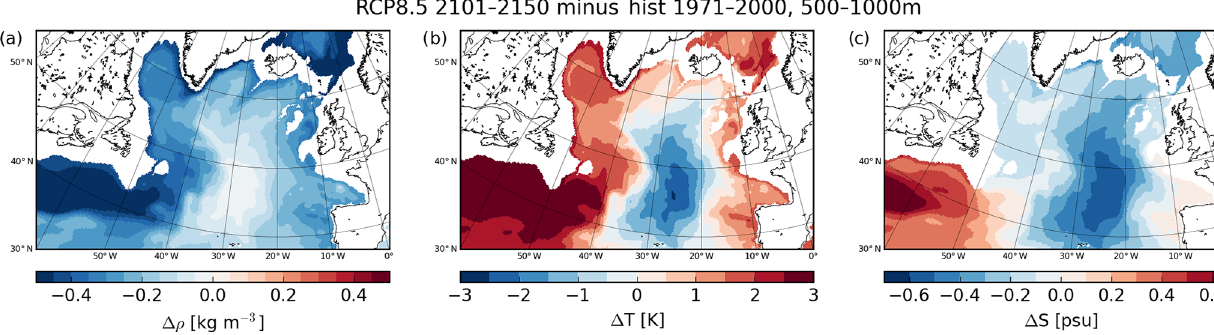
Figure 10. Ensemble means of projected changes (RCP8.5 2101–2150 E0 minus historical 1971–2000) in annual means of seawater den-